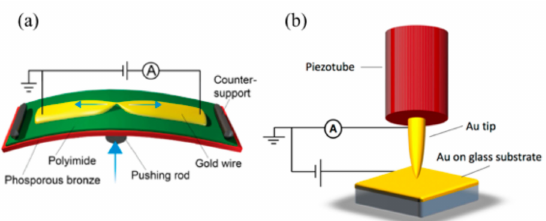
Figure 2. ( a ) Sketch of the mechanically controlled break junction MCBJ setup (from Reference [23]). The sample is bent and consequently broken by moving the pushing rod up; ( b ) schematic